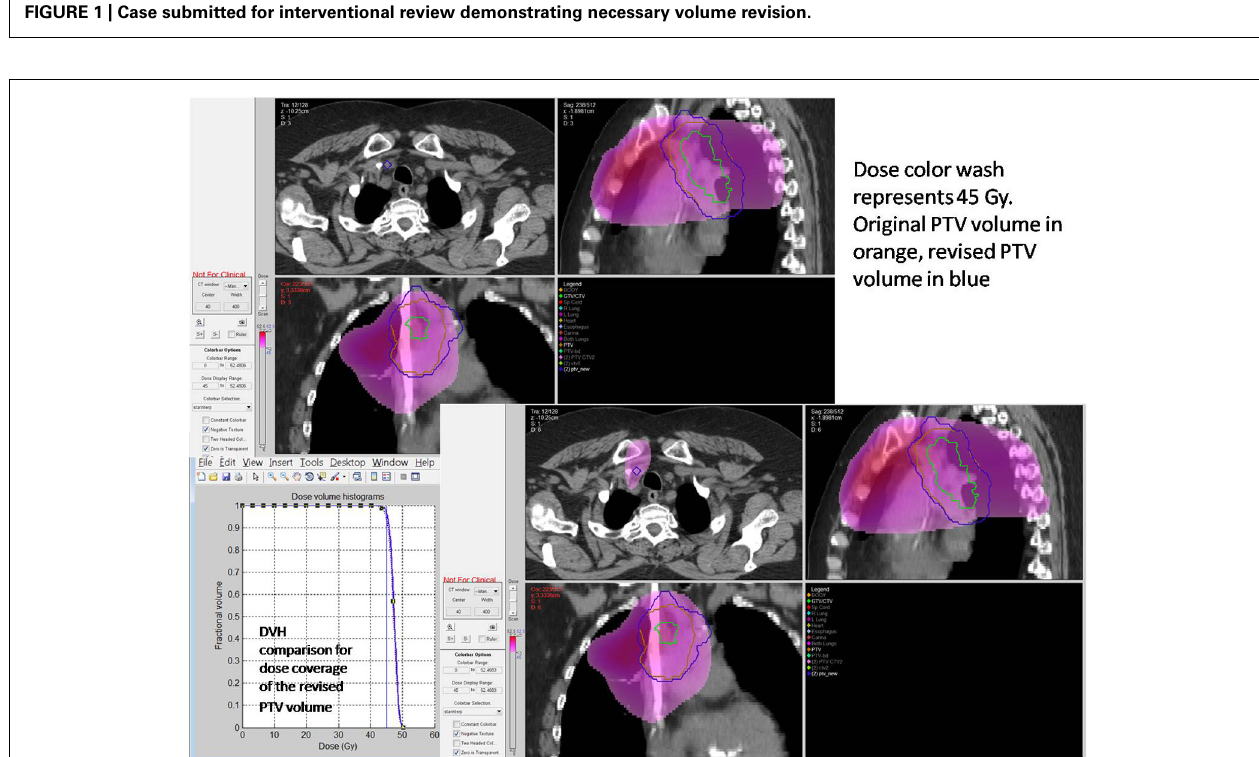
FIGURE 2 | Case submitted for interventional review in Figure 1 demonstrating improved dose coverage.